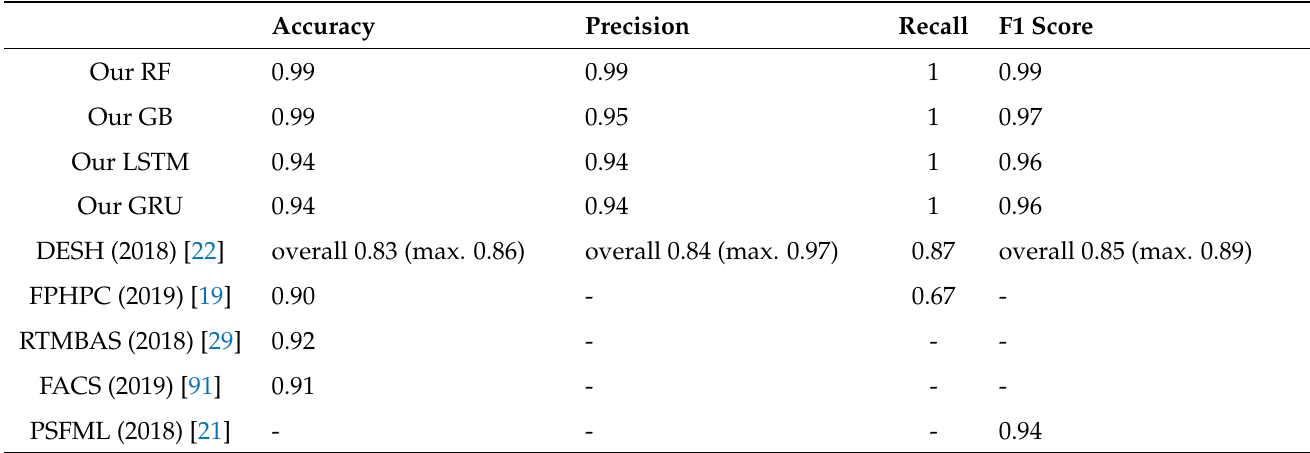
Table 8. Experimental result and its comparison to the state-of-the-art. Accuracy Precision